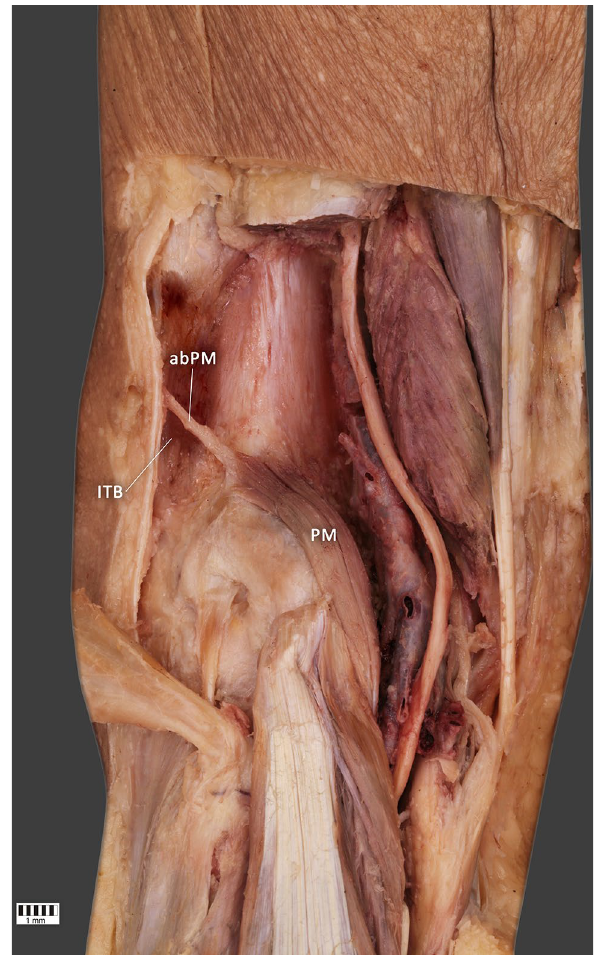
Figure 4. Type of origin of the plantaris muscle. ( a , b ) PM accessory band of the plantaris muscle. PM plantaris muscle; ITB iliotibial